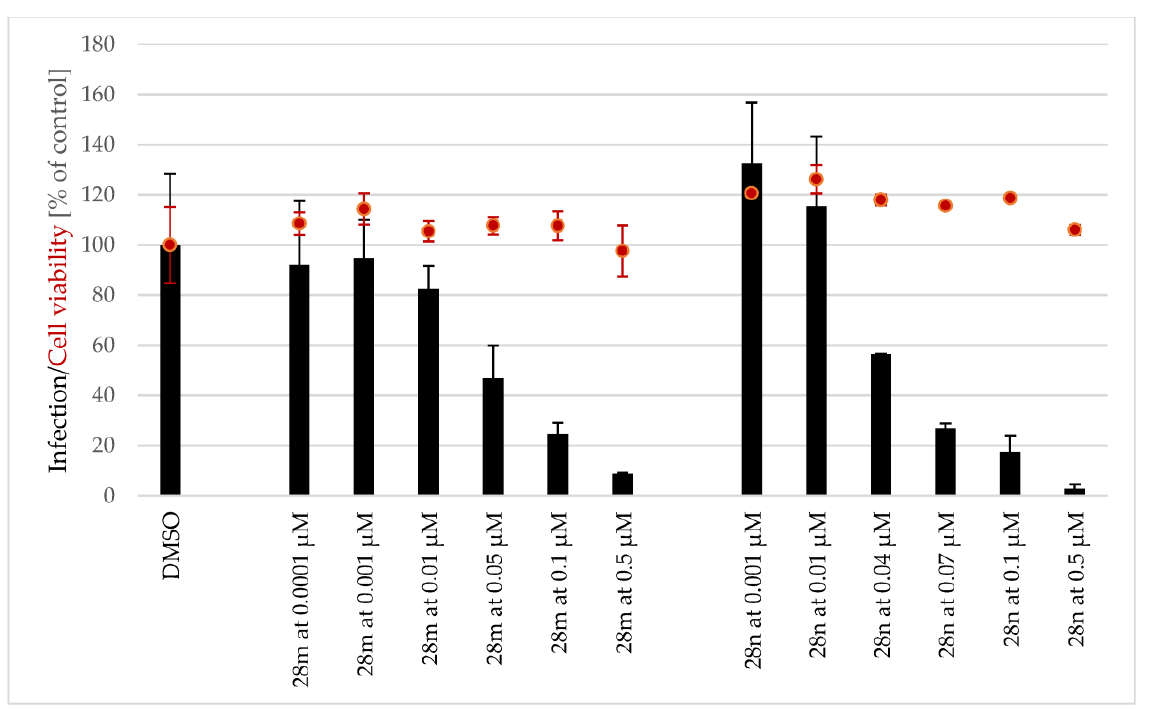
Figure 6. Inhibition of hepatic stage of Plasmodium berghei in Huh-7 cell line—IC 50 determination of two the most active compounds— 28m and 28n